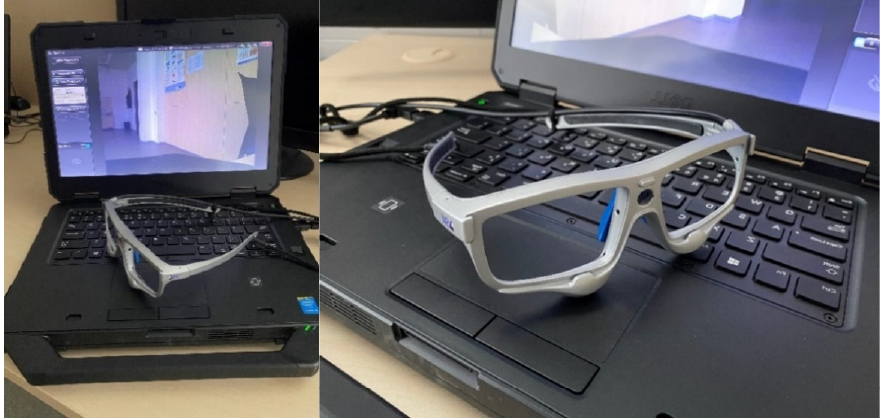
Figure 5. SMI Eye Tracking 2 Wireless. Source: own collaboration.